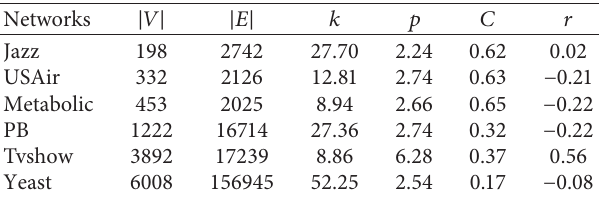
Table 2: Structural features and basic information of six real-world